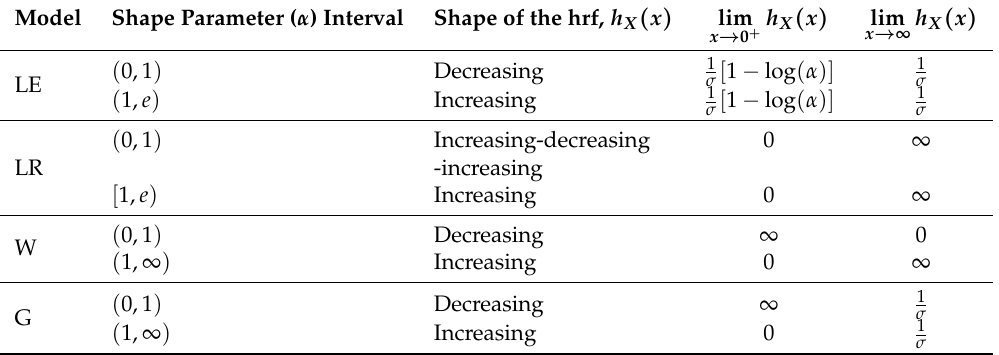
Table 2. Comparison of the Lambert-exponential (LE), Lambert–Rayleigh (LR), Weibull (W) and gamma (G) models in terms of the